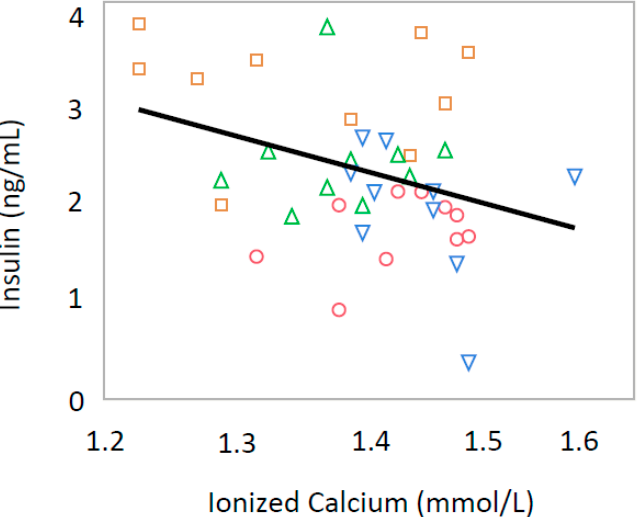
Figure 4. Relationship between serum ionized calcium and serum insulin levels in both male and female rat offspring (R = − 0.370, p = 0.0270). Green triangle, male offspring from control group; square, male offspring from Ca-deficient group; circle, female offspring from control group; blue inverse triangle, female offspring from Ca-deficient group.